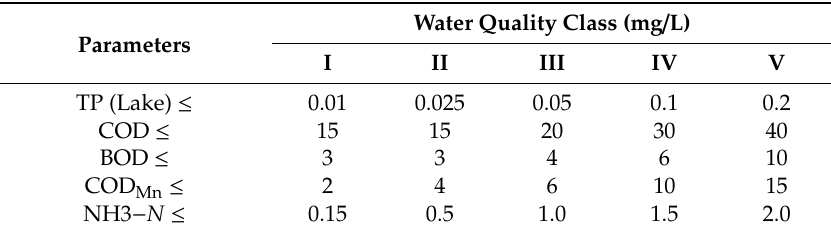
Table 3. Main parameter standard of water quality